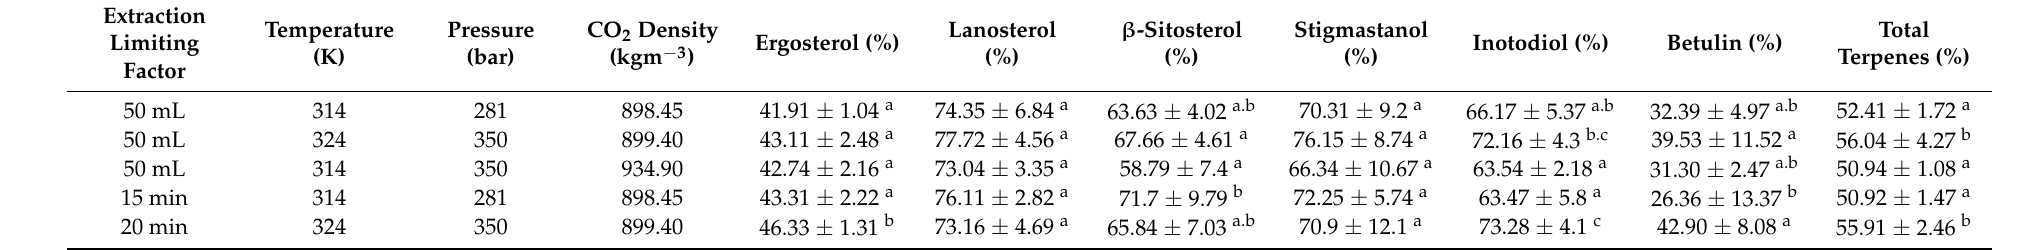
Table 4. Proportion ( w / w %) of single compounds and total triterpenoids obtained with SFE in relation to the amount obtained with Folch extraction. The different letters (a–c) indicate significant difference ( p <